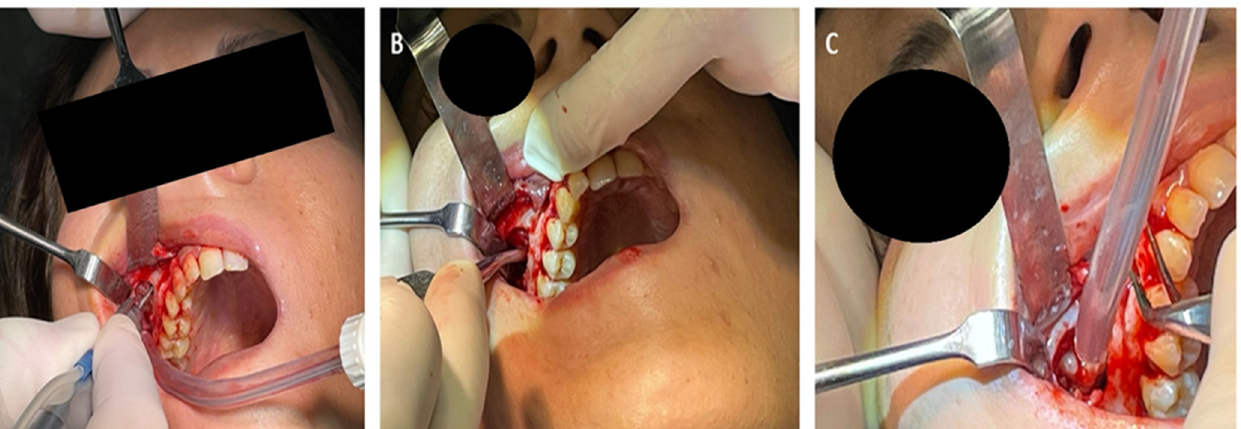
Figure 2. Coronal section shows wisdom tooth much higher with part of the crown and all part of the roots in the distal wall of the sinus maxillary and above the second molar.